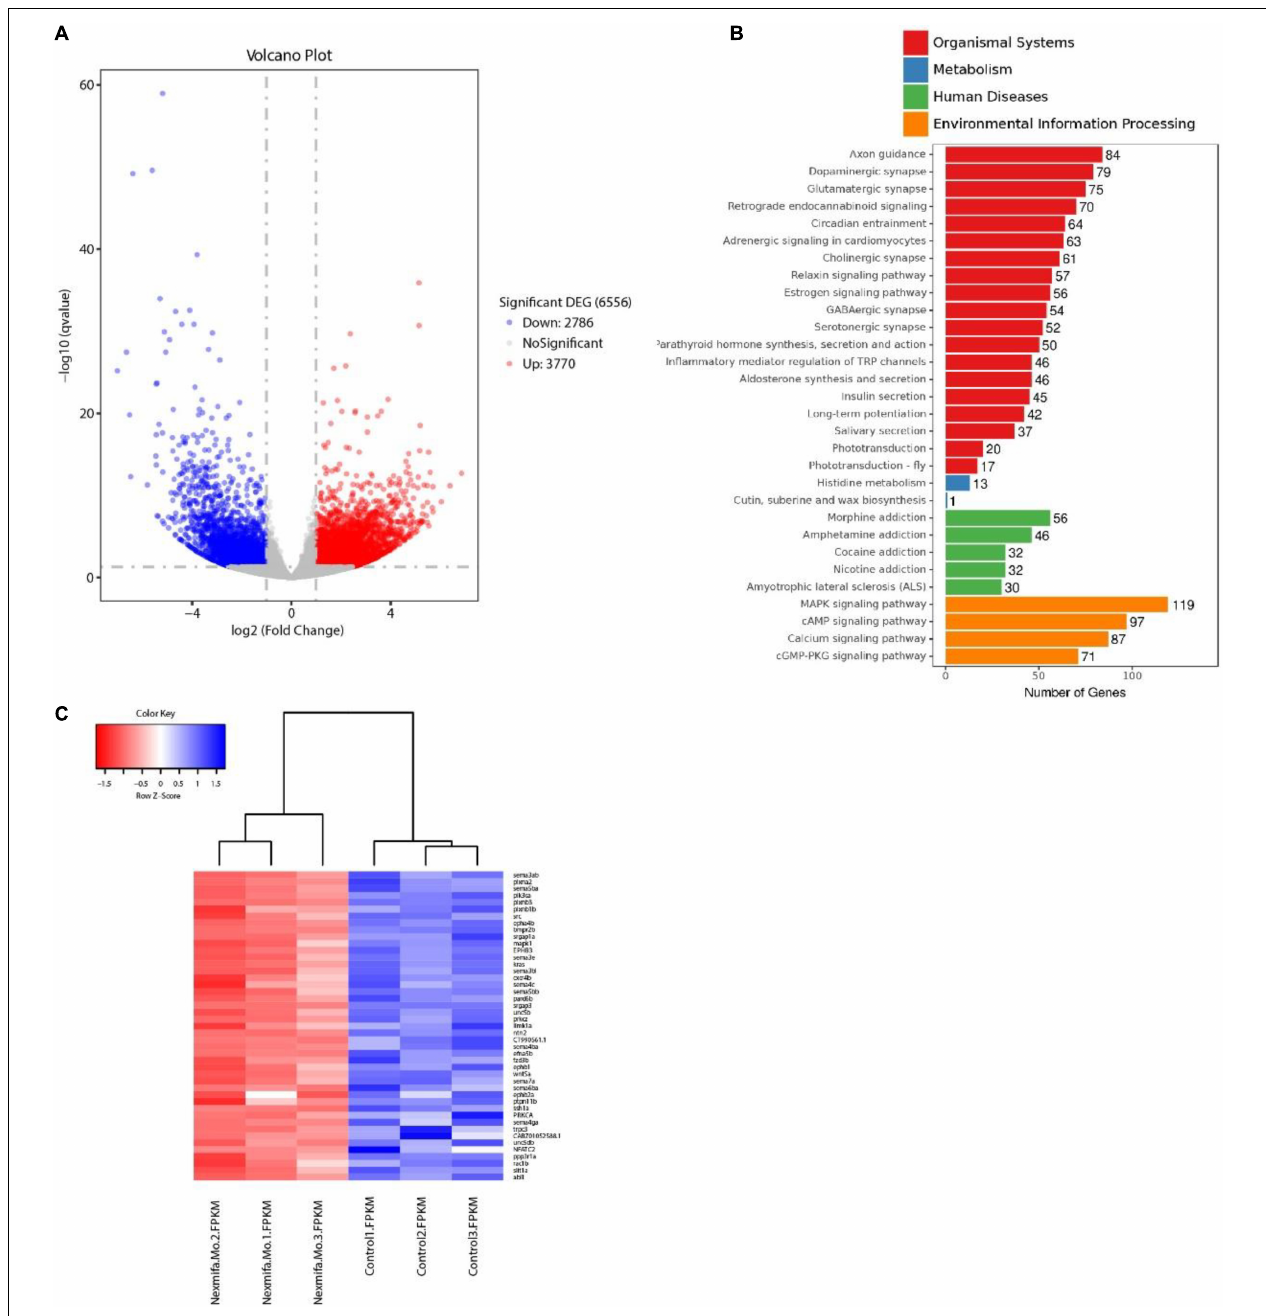
FIGURE 5 | Transcriptomics profiling in nexmifa morphant and wild-type zebrafish. (A) Volcano map showing DEGs in control and nexmifa morphants. Red and blue spots represent up-regulated and down-regulated genes, respectively. (B) KEGG pathway annotation of DEGs in control and nexmifa morphants. (C) Heatmap pathway differences between control and nexmifa morphants showing down-regulated genes in axon guidance.